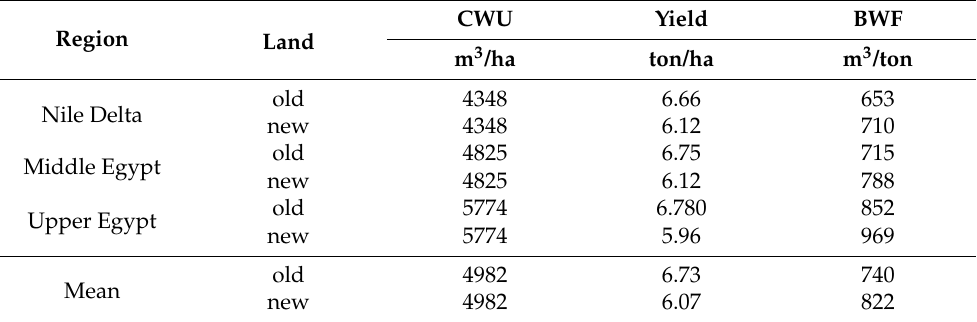
Table 3. Crop water use (CWU m 3 /ha), wheat yield (ton/ha) and blue water footprint for different climate regions in old and new lands.